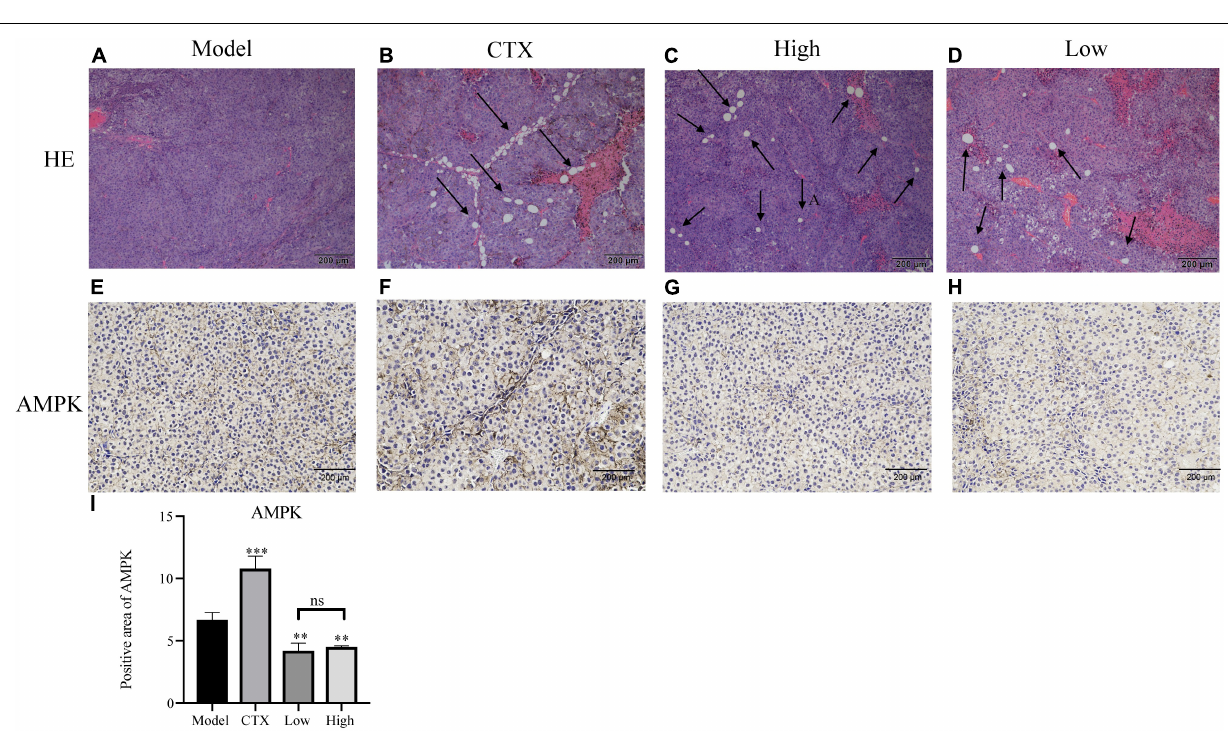
difference was found between the doses ( Figures 7F–I ).